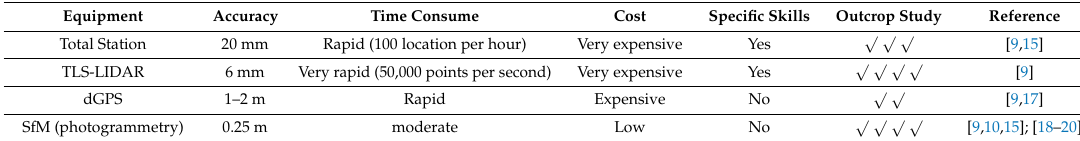
Table 1. The comparison of the used survey equipment for outcrop study.